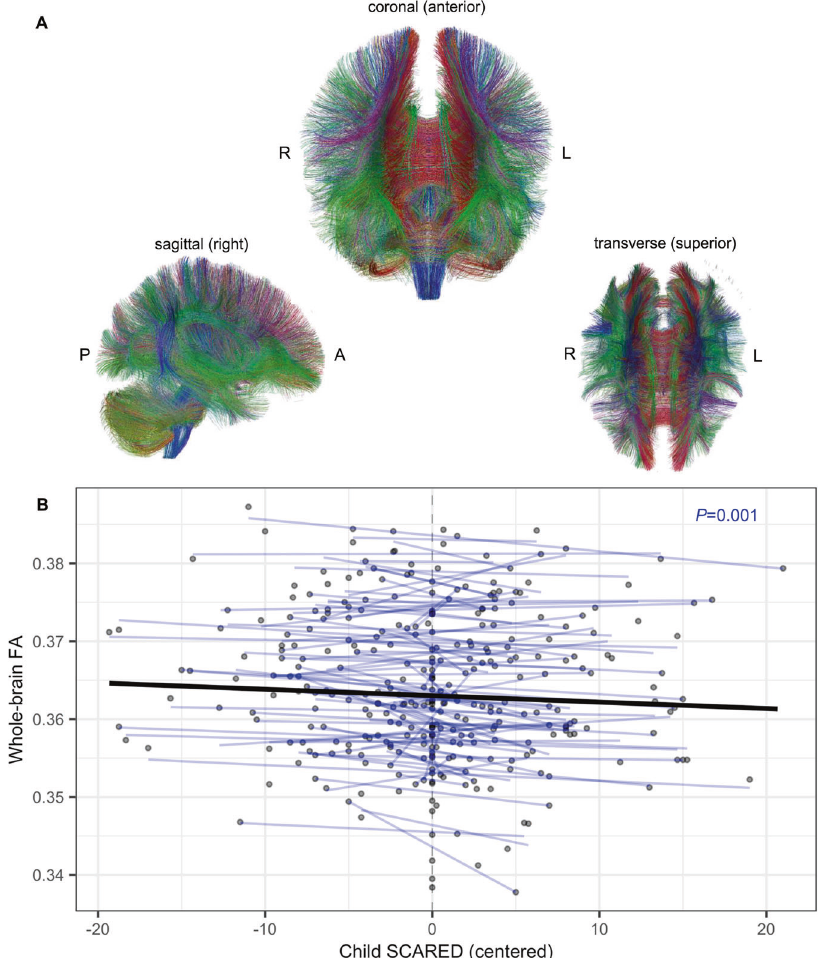
Fig. 2 Longitudinal within-participant association of whole-brain FA with child SCARED scores. A Coronal, sagittal, and transverse views of a 3-D rendering of whole-brain WM tracts, as generated via deterministic tractography in TrackVis (A-P anterior-posterior; R-L right-left). Green fi bers extend along anterior-posterior axis; red fi bers along the medial-lateral axis; and blue fi bers along the superior-inferior axis. B Within- participant relationship between whole-brain FA and child SCARED scores. Each blue line represents a participant-speci fi c regression line predicting whole-brain FA from within-participant centered child SCARED scores, while controlling for age. Each point represents an individual scan. The bolded black line depicts the average within-participant association of whole-brain FA with child SCARED